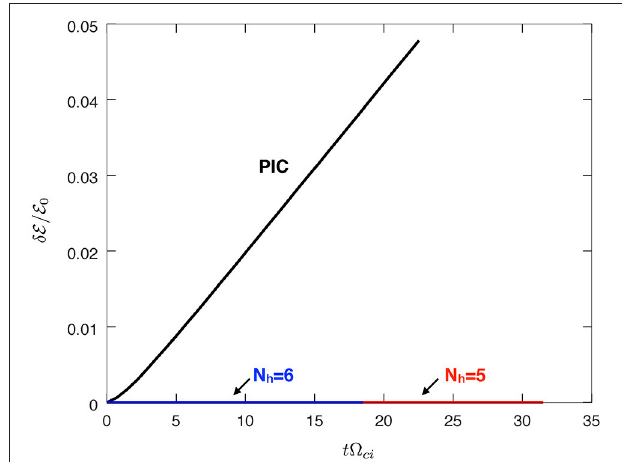
FIGURE 7 | Energy conservation in the simulation of decaying turbulence. The curves show evolution of total energy E in the simulation, which is the kinetic energy of plasma species plus the energy of the electromagnetic field, normalized to the energy of the initial perturbation δ E ( t )